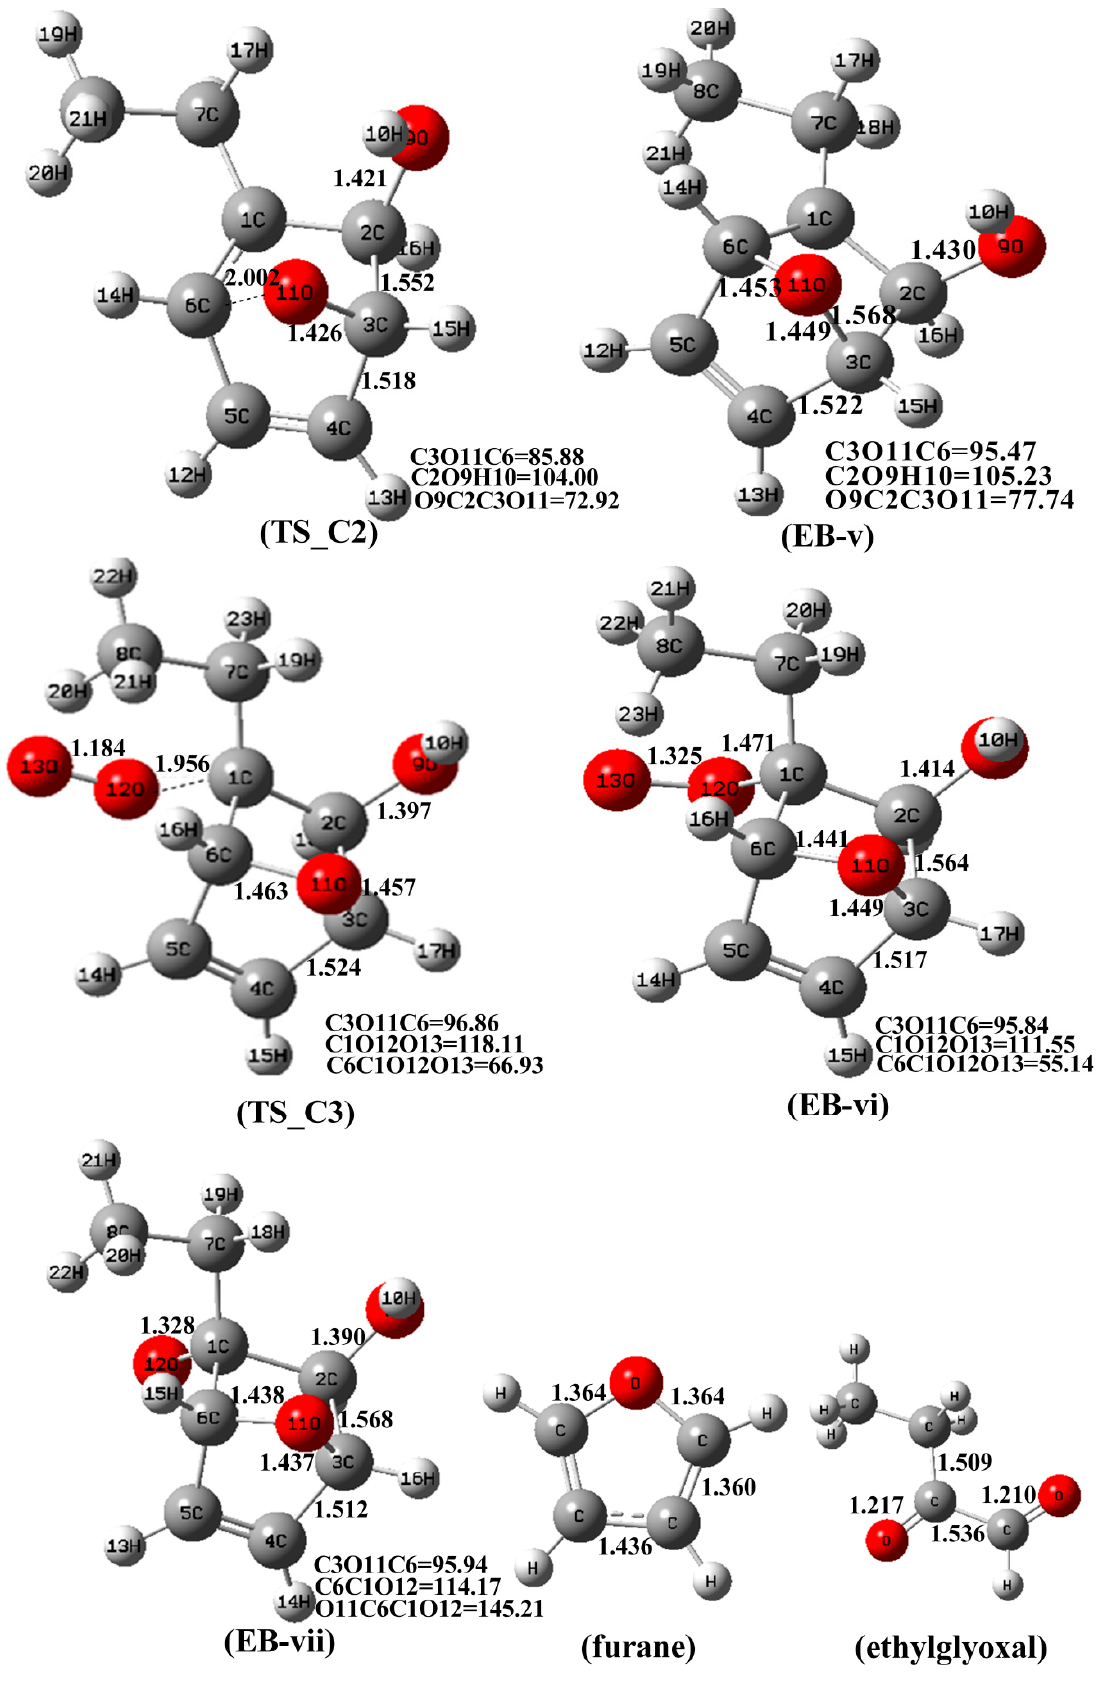
Figure 5. Optimized geometries of various species of Path C for the formation of furane and ethyl-glyoxal, as shown in Figure 1, at the BHandHLYP/6-311++G(d,p) level (Bond length: Å, Bond angle: °).